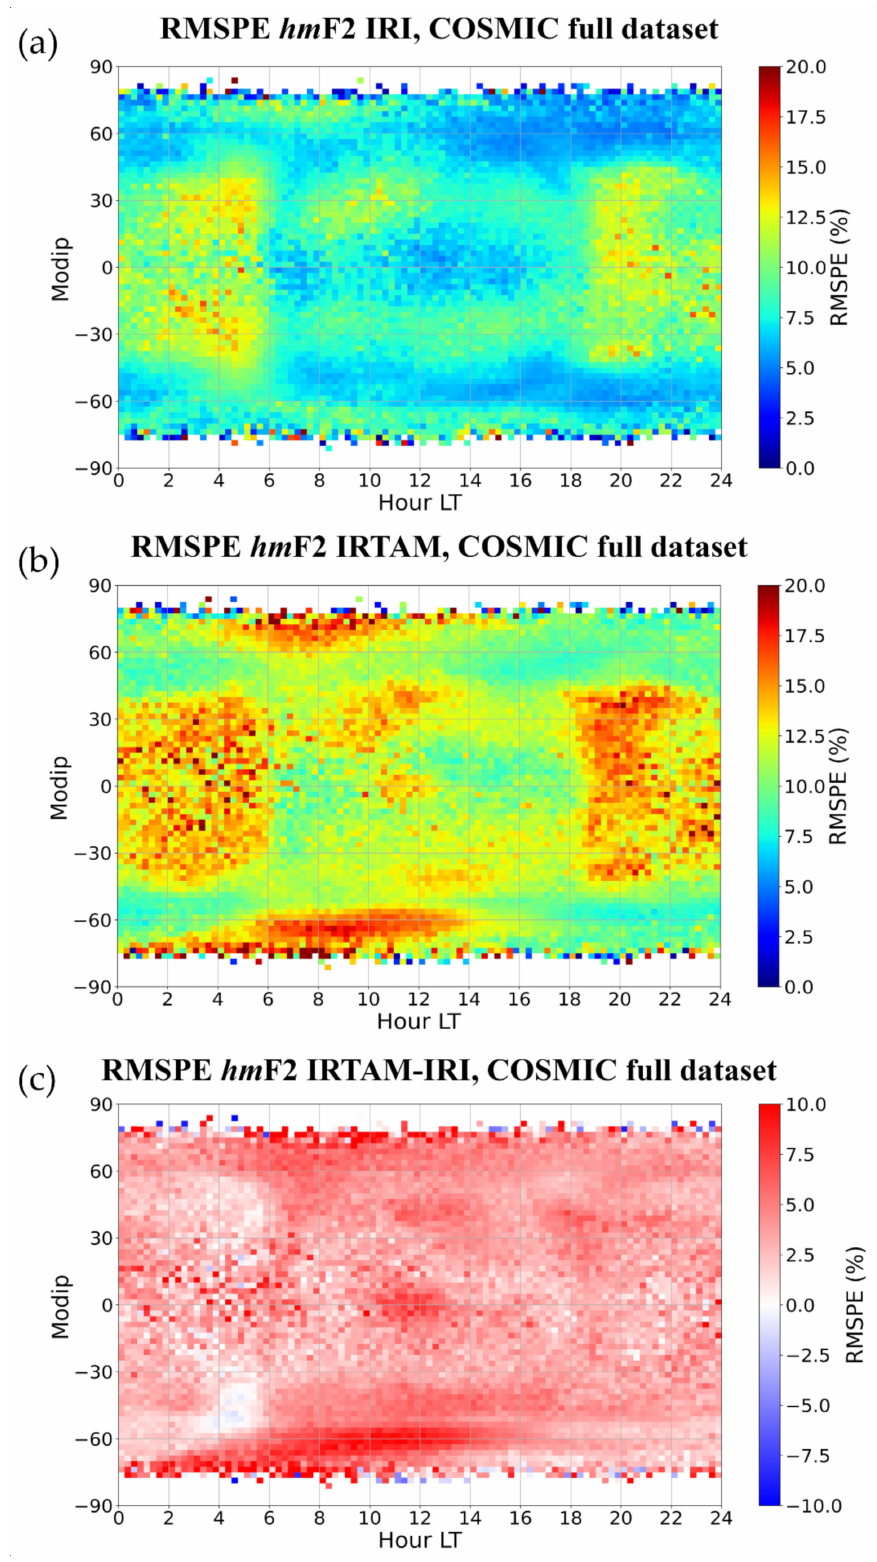
Figure 42. Grids of binned RMSPE values calculated between hm F2 values measured by COSMIC satellites and modeled by ( a ) IRI and ( b ) IRTAM, and ( c ) the corresponding grid of differences. Data were binned as a function of the LT (fifteen minute-wide bins) and modip (2.5 ◦ -wide